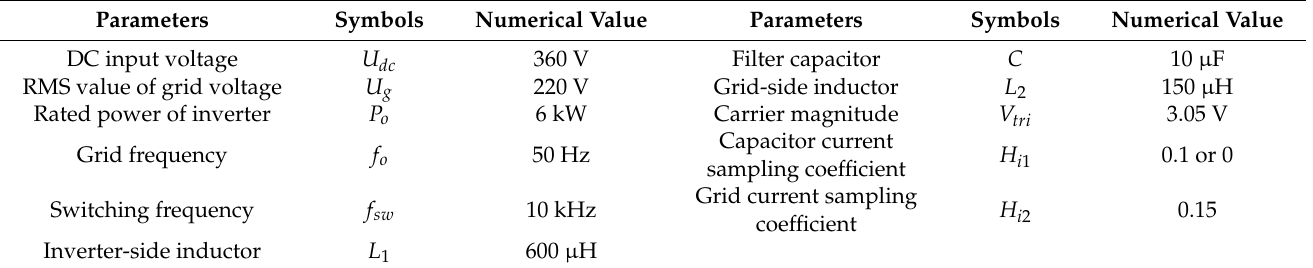
Table 3. Single-phase GCI parameters [47].